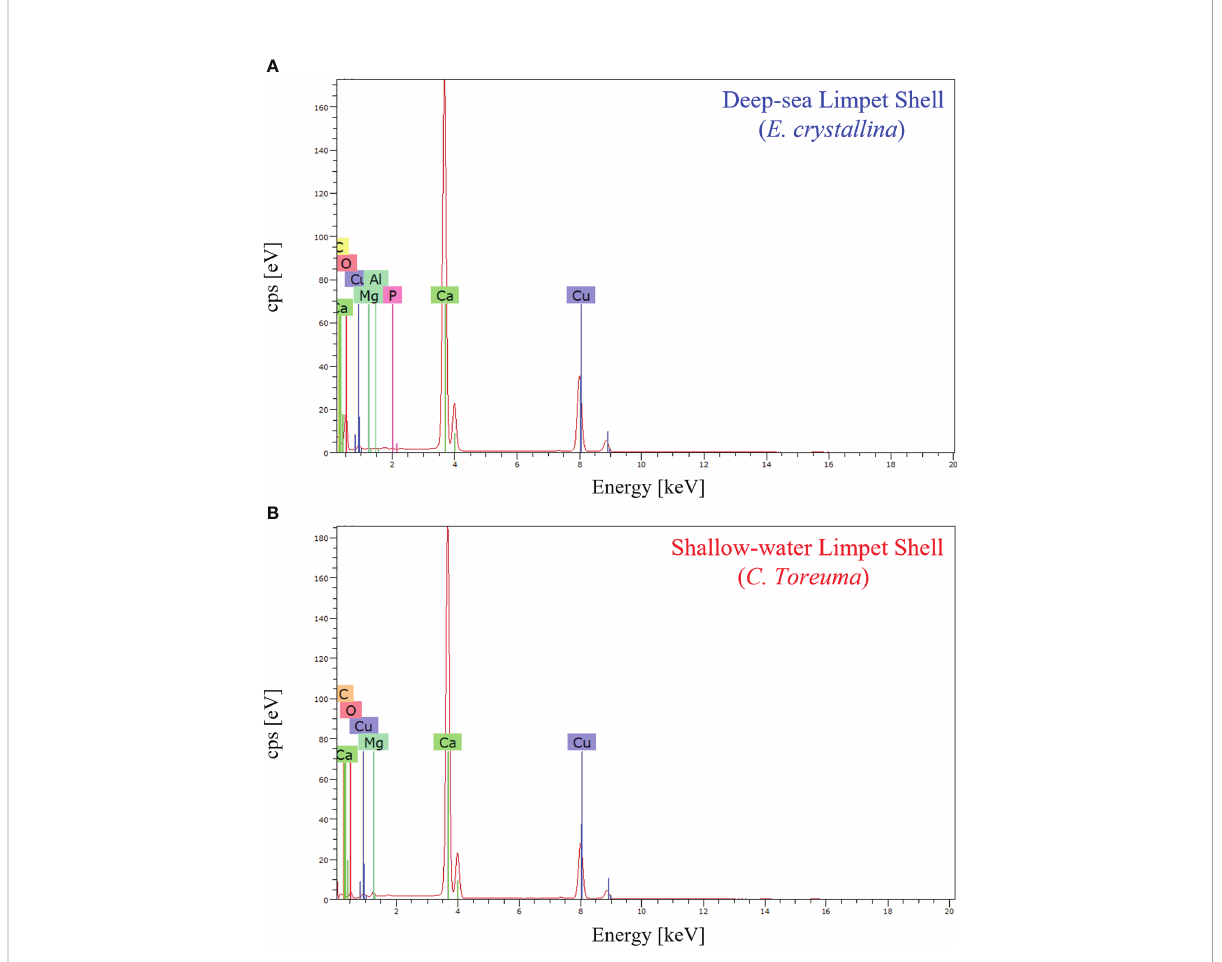
FIGURE 6 The EDS spectra of (A) deep-sea limpet E. crystallina shells containing Ca, C, and O as the main components and P and Al as unique trace elements and (B) shallow-water limpet C. toreuma shells containing Ca C, and O as the main components, where the Cu signal generates from the TEM copper grid used for EDS